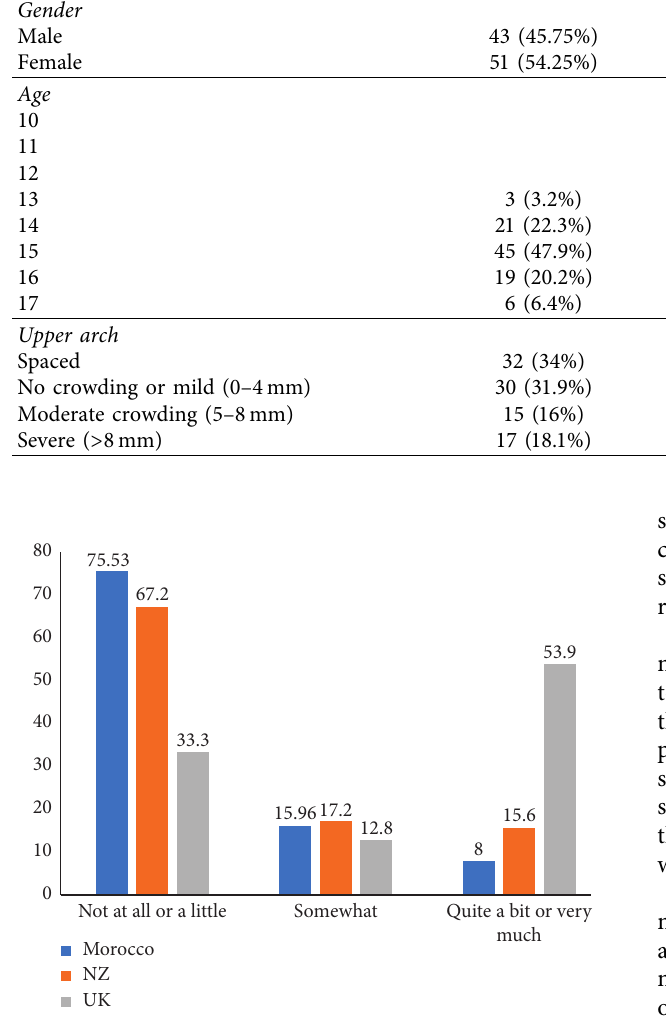
Figure 4: Responses of the Moroccan, NZ, and UK participants to the first global